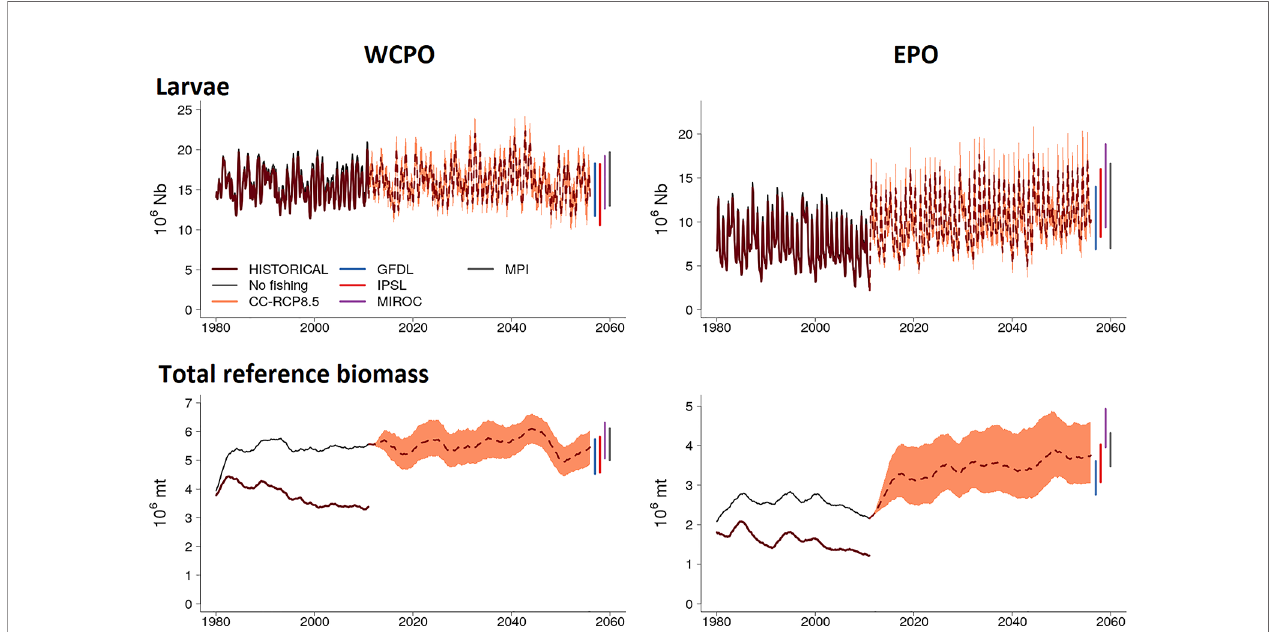
FIGURE 4 | Envelope of predictions of larvae and total biomass computed from simulation ensembles under IPCC RCP8.5 scenario for the western central (WCPO) and eastern (EPO) Paci fi c Ocean. The change in larvae and total biomass, from 2011 onwards, is presented with the average (dotted line) and its envelope bounded by the 5% and 95% quantile values of the simulation